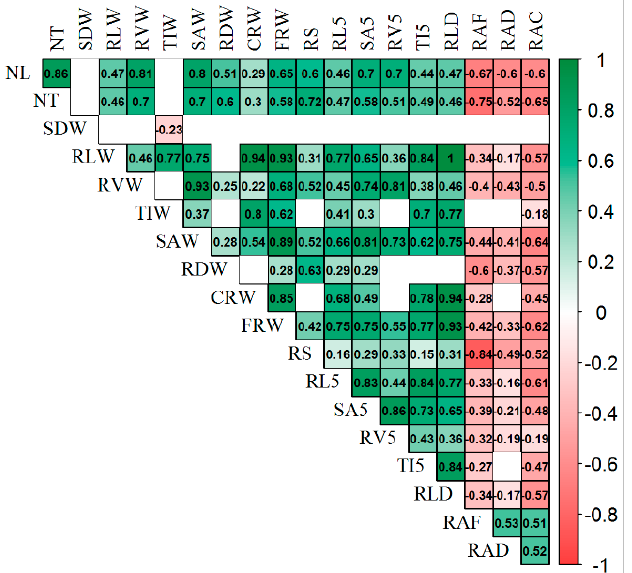
Figure 7. Positive significant correlation (in green) and negative significant correlation (in red) among all traits under drought conditions and root angle under different conditions. NL—number of leaves; NT—number of tillers; SDW—shoot dry weight; RVW—total root volume; RLW—sum of all root lengths; TIW—total number of tips; RDW—root dry weight; SAW—total root surface area, RLD—root length density, CRW—total number of crossings; FRW—total number of forks; RS—root shoot ratio; RL5—sum of root lengths in the first 5 cm below the ground; SA5—root surface area in the first 5 cm below the ground; TI5—number of tips in the first 5 cm below the ground; RV5—root volume in the first 5 cm below the ground; RAC—root angle of plants grown in greenhouse as control; RAD—root angle of plants grown in greenhouse under drought conditions; RAF—root angle of plants grown in the field.